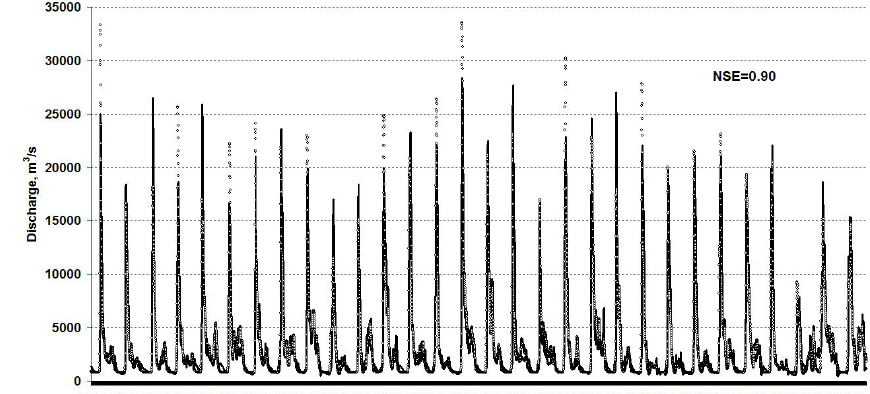
Figure 2. Observed (solid line) and simulated (points) hydrographs of the Northern Dvina river.